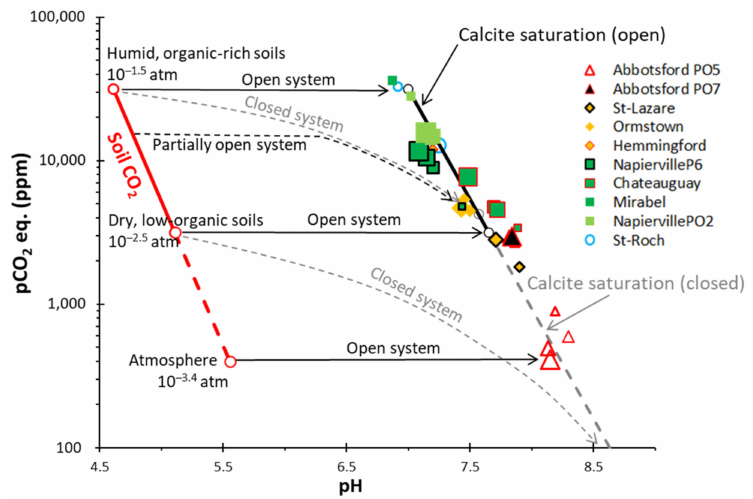
Figure 13. (Modified from Clark [32]): Samples pCO 2 as a function of pH, shown together with saturation equilibriums for calcite and pCO 2 at the recharge (soil and